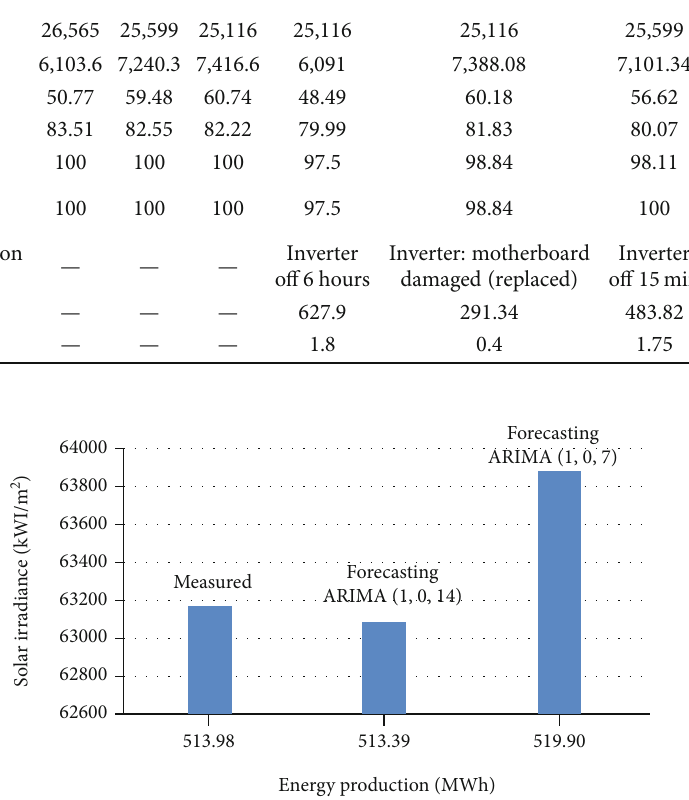
Table 9: Main results of the energy production by the experimental PV park from Grojdibodu forecasted for the period 01-09.08.2013. Day Hours when the inverter is running